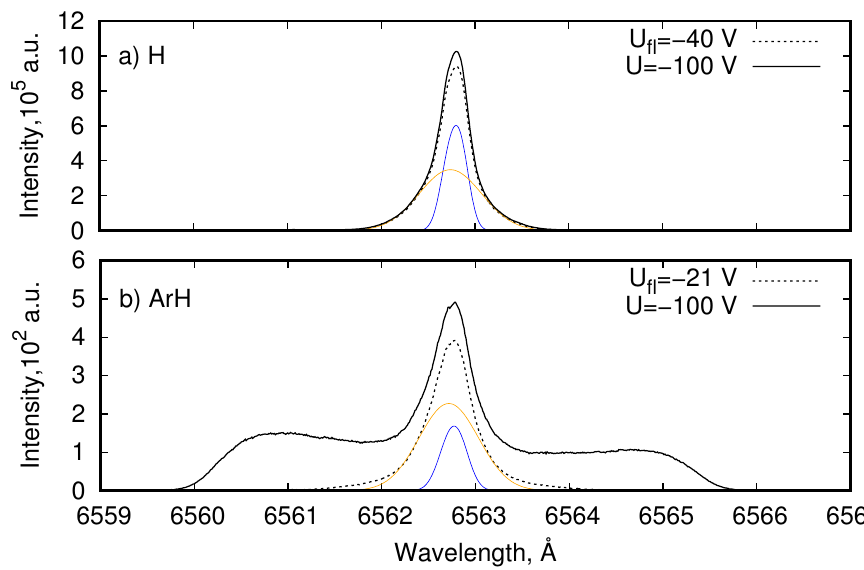
Figure 5. Emission of the Balmer- α line measured at PSI-2. The angle of observation to the Pd mirror is 35 ◦ . ( a ) Emission in the case of pure H plasma. Gas flow of H, F H 2 = 85 sccm, the gas pressure p = 4.7 × 10 − 2 Pa. ( b ) Emission in the case of ArH plasma. The gas flow of Ar, F Ar = 50 sccm, and the gas flow of H, F H 2 = 30 sccm; the gas pressure p = 4.1 × 10 − 2 Pa. The dashed line corresponds to the measurements at floating potential and the solid black line to the measurements at the applied voltage of − 100 V. The blue and the orange curves are the components of the passive line obtained according to [21].